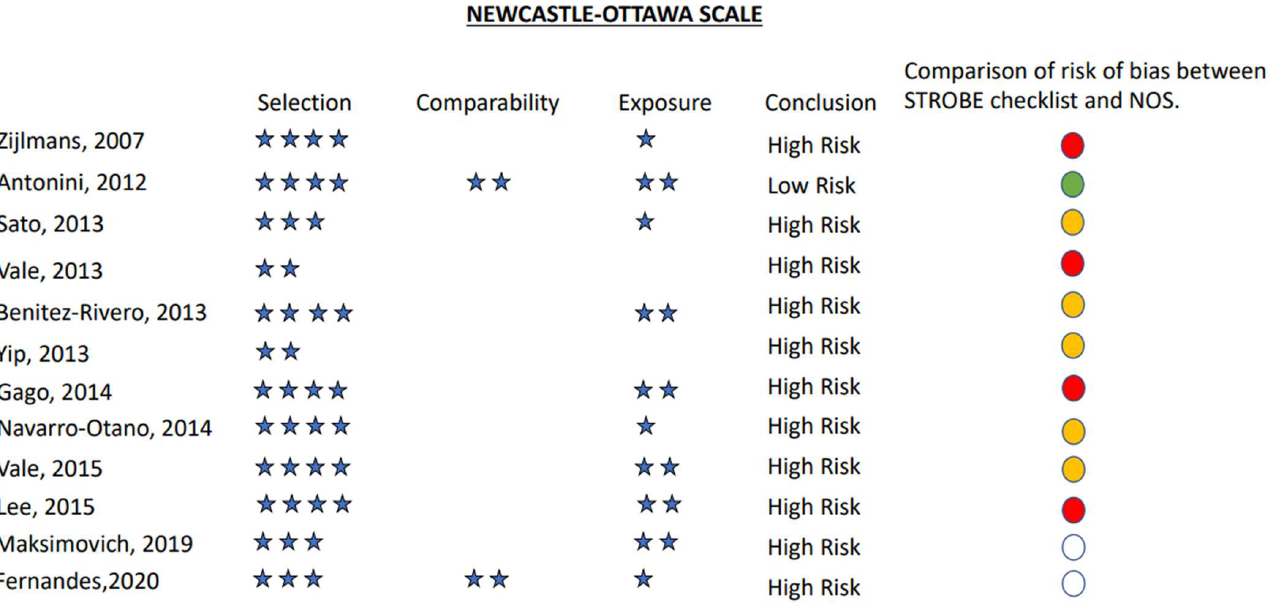
Figure 2. Newcastle–Ottawa scale and comparison of bias with STROBE scale.